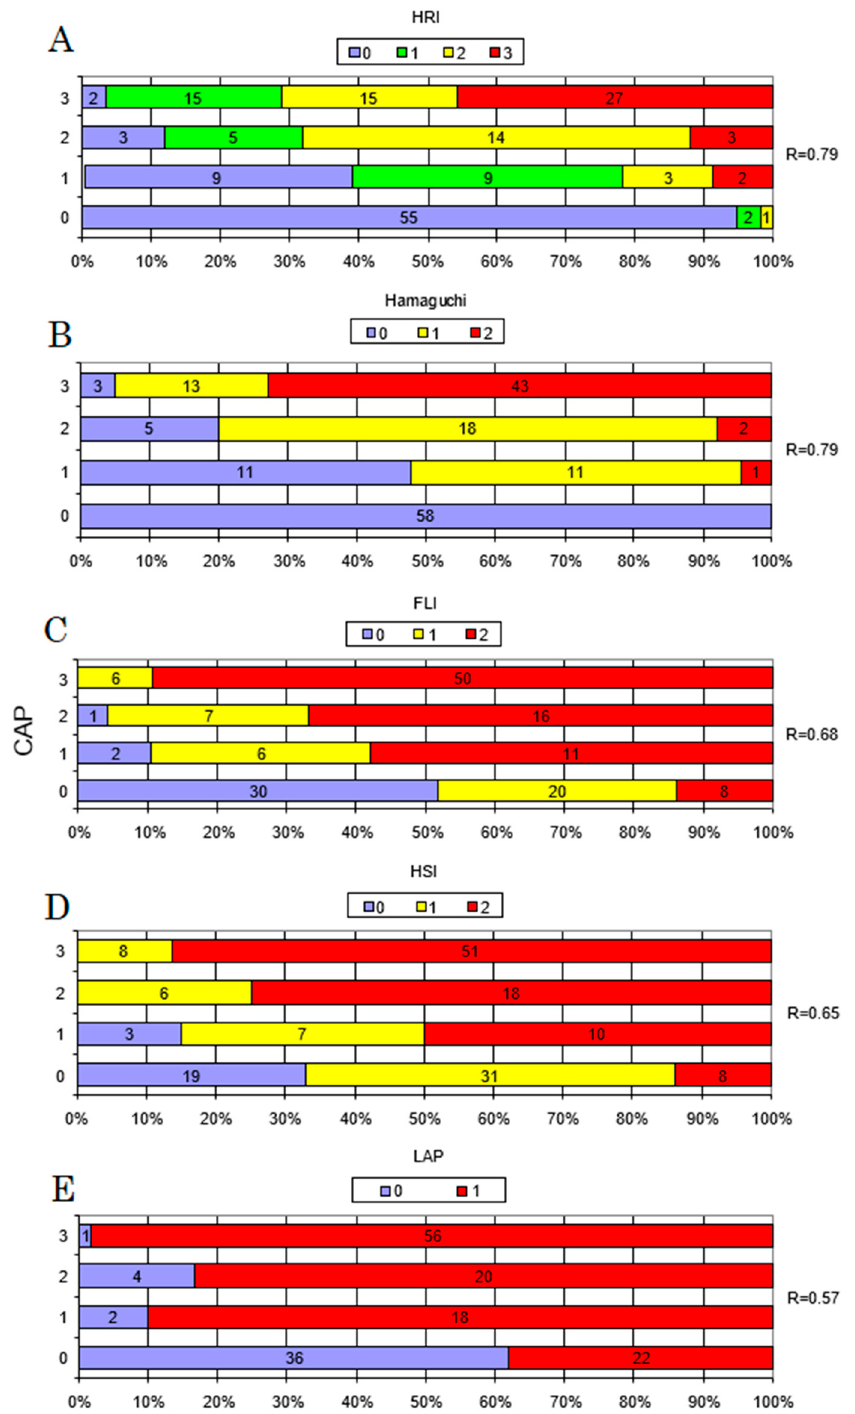
Figure 4. Discrepancies between controlled attenuation parameter (CAP) steatosis grades and hepatorenal index (HRI), Hamaguchi’s score, fatty liver index (FLI), hepatic steatosis index (HSI), and lipid accumulation product (LAP) steatosis grades. Comparison between classification of liver steatosis according to CAP and HRI ( A ), Hamaguchi’s score ( B ), FLI ( C ), HSI ( D ), and LAP ( E ). The Spearman’s rank (R) coefficient was calculated to analyse the inter-rater reliability between ordinal diagnostic scales and liver steatosis severity established by CAP. CAP grades S1–S3 are described according to Karlas et al. [10], with cut-off values of 234, 269, and 301 dB/m, respectively.